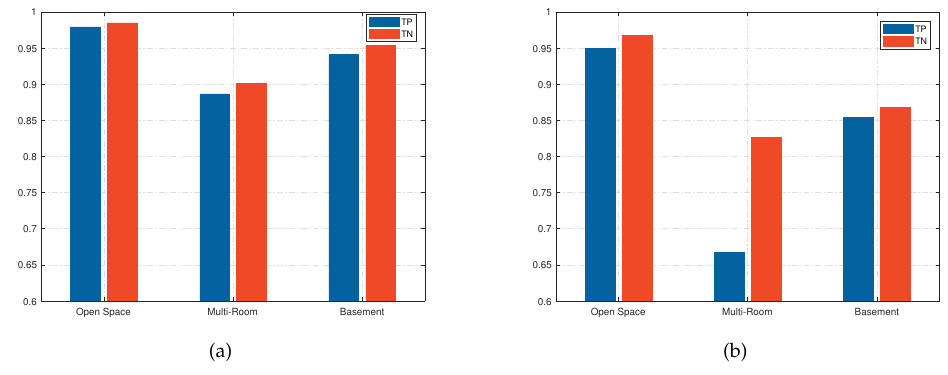
Figure 16. Detection results. ( a ) B-SVC. ( b ) Naive Bayes Classification.